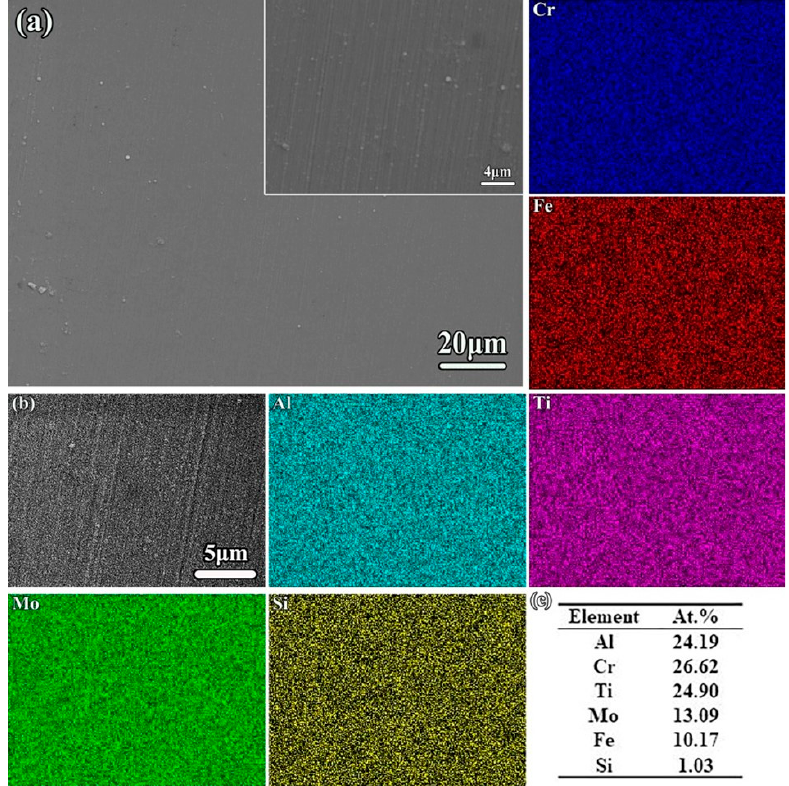
Figure 3. The surface SEM image ( a ) of the as − deposited AlTiCrFeMoSi coating and surface EDS results ( b , c ) on the T91 substrate.